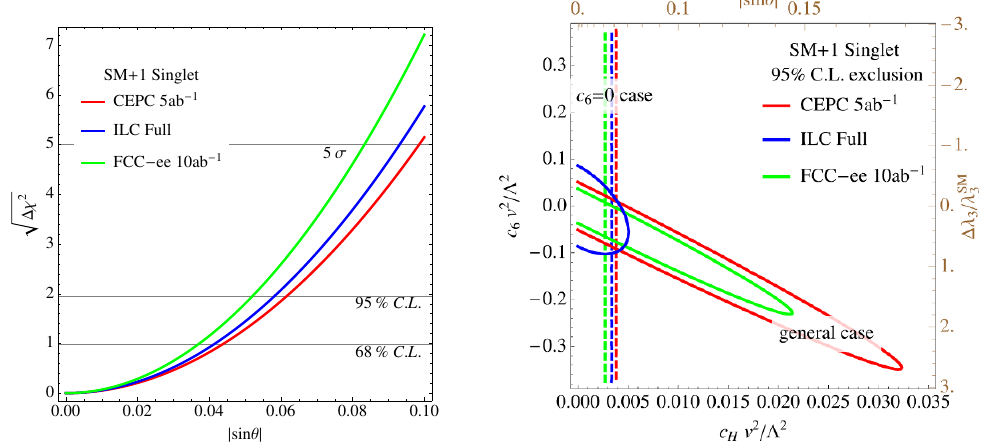
Figure 1 . For SM plus one real singlet model, left panel shows the (cid:1) (cid:31) 2 as a function of the singlet- SM Higgs doublet mixing angle j sin (cid:18) j in the Z 2 -breaking case for CEPC (red), FCC-ee(green) and ILC (blue) from Higgs precision measurements. Right panel shows the 95% C.L. limit on the Wilson coe(cid:14)cient c 6 v 2 = (cid:3) 2 vs. c H v 2 = (cid:3) 2 . The vertical dashed lines indicate the one parameter (cid:12)t limit on c H v 2 = (cid:3) 2 with c 6 set to be 0. The corresponding values of the mixing angle j sin (cid:18) j and changes to trilinear Higgs coupling (cid:1) (cid:21) 3 =(cid:21) SM are shown in the upper and right axes of this 3